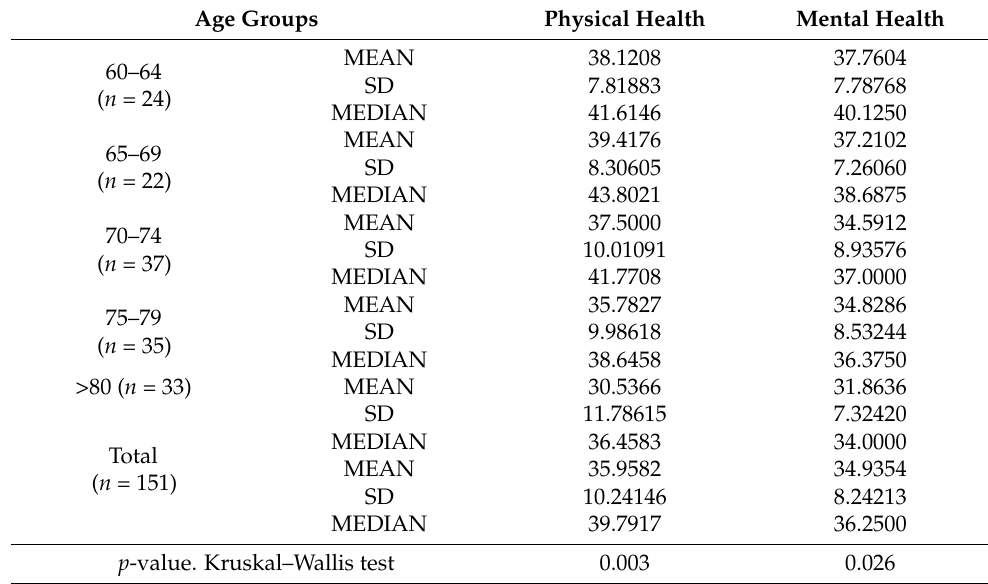
Table A3. Summary Measures according to the Age of Patients Operated on for AAAs.